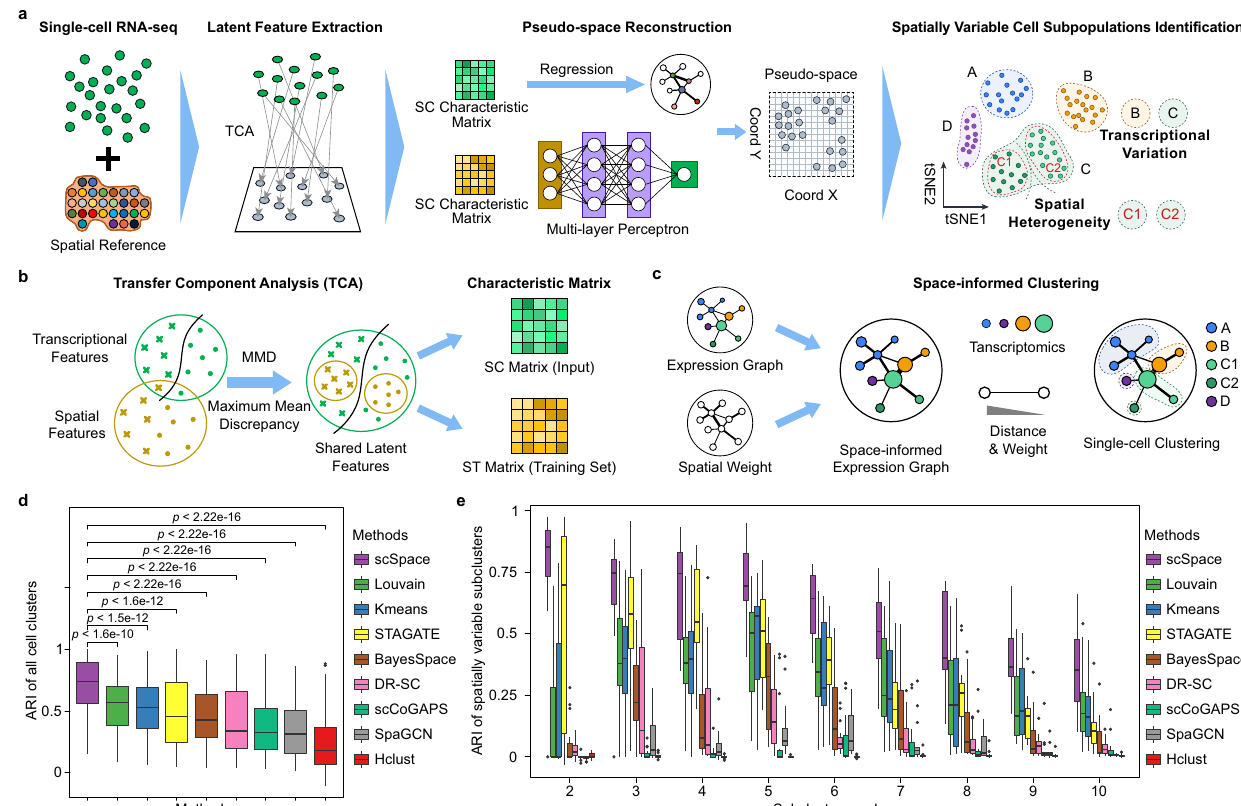
Fig. 1 | Schematic work fl ow of scSpace and performance evaluations on simu- lateddata.a OverviewofthedesignconceptofscSpace.GiventhescRNA-seqdata (SC) and spatial transcriptomics reference (ST), scSpace co-embeds these two types of data into a shared latent space and extracts the shared latent features. Using the characteristic matrix from ST data, scSpace trains a multi-layer percep- tron model with spatial coordinates as the outcome and latent features as the predictors. The trained model is then applied to the characteristic matrix from SC dataforpseudo-spacereconstruction.Basedonthegeneexpressionpro fi lesaswell as the pseudo-space information, scSpace identi fi es the spatially variable cell subpopulations from scRNA-seq data. b Conceptual framework of latent feature extraction with scSpace. A transfer learning method termed transfer component analysis (TCA) is applied to extract the shared latent feature representation across scRNA-seq and spatial transcriptomics data. TCA fi rst projects the scRNA-seq and spatial transcriptomics data into a Reproducing Kernel Hilbert Space (RKHS), and then reduce the difference in the distribution of transformed two domain data by minimizing the maximum mean discrepancy (MMD) between them. The shared